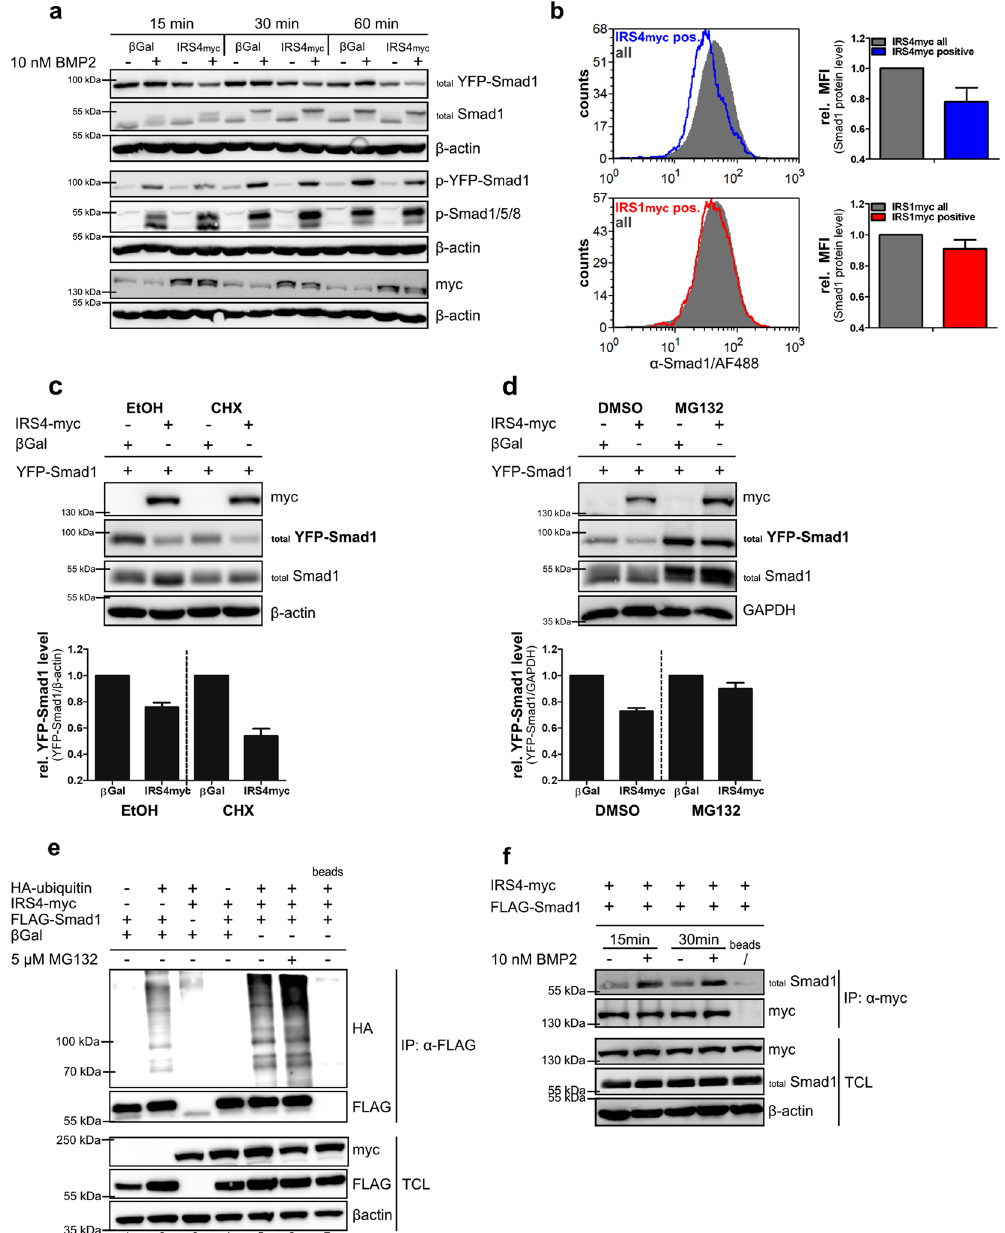
Figure 2. IRS4 causes reduction of Smad1 levels. ( a ) IRS4 expression reduces Smad1 protein. Transfected C2C12 cells were stimulated with 10 nM BMP2 for the indicated times. Lysates were analysed by Western blotting using indicated antibodies. ( b ) IRS4 interferes with endogenous Smad1 protein levels. Transfected C2C12 cells were gated on myc-positive single cells (blue and red curve) via flow cytometry and endogenous Smad1 levels were analysed. Median fluorescence intensity (MFI) values of myc-positive cells were compared to those of all cells (grey curves). Bar charts represent means ± SD of 3 independent experiments. ( c , d ) The Smad1 decrease is mediated via proteasomal degradation. Transfected C2C12 cells were incubated with 5 µ g/ ml cycloheximide ( c ) or 10 µ M MG132 ( d ) for 6 h; ethanol and DMSO were applied as respective vehicle control. Lysates were subjected to Western blotting. Quantification depicts total YFP-Smad1 level normalised to β -actin or GAPDH relative to β -galactosidase. Bar charts represent mean ± SD from 3 independent experiments. ( e ) IRS4 enhances ubiquitination of Smad1. Transfected HEK293T cells were incubated with 5 µ M MG132 overnight and subjected to immunoprecipitation of FLAG-Smad1 using an α -FLAG antibody. Immunoprecipitates and TCL were analysed by Western blotting using indicated antibodies. Incubation with beads only served as IP control. ( f ) IRS4 interacts with Smad1. Transfected HEK293T cells were stimulated with 10 nM BMP2 for indicated times. Immunoprecipitation was performed using α -myc antibody; precipitates and TCL were analysed by Western blotting. Incubation with beads only served as IP control. To analyse different proteins in the same samples simultaneously, membranes were cut accordingly and incubated with respective antibodies separately. For a clear and concise data presentation, displayed blots were cropped